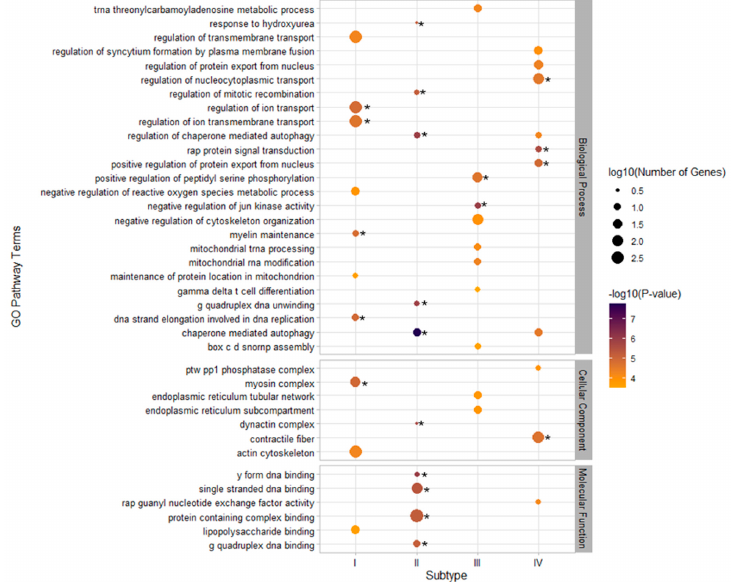
Figure 4. Gene ontology pathway enrichment analysis for metabolic subtypes ◊ . ◊ Subtype I, adiposity-dominant type; Subtype II, hypertension-dominant type; Subtype III, hyperglycemia-dominant type; Subtype IV, dyslipidemia-dominant type. The top 10 gene sets for each subtype are shown, with significant gene sets marked with an “*” after conducting Bonferroni correction.